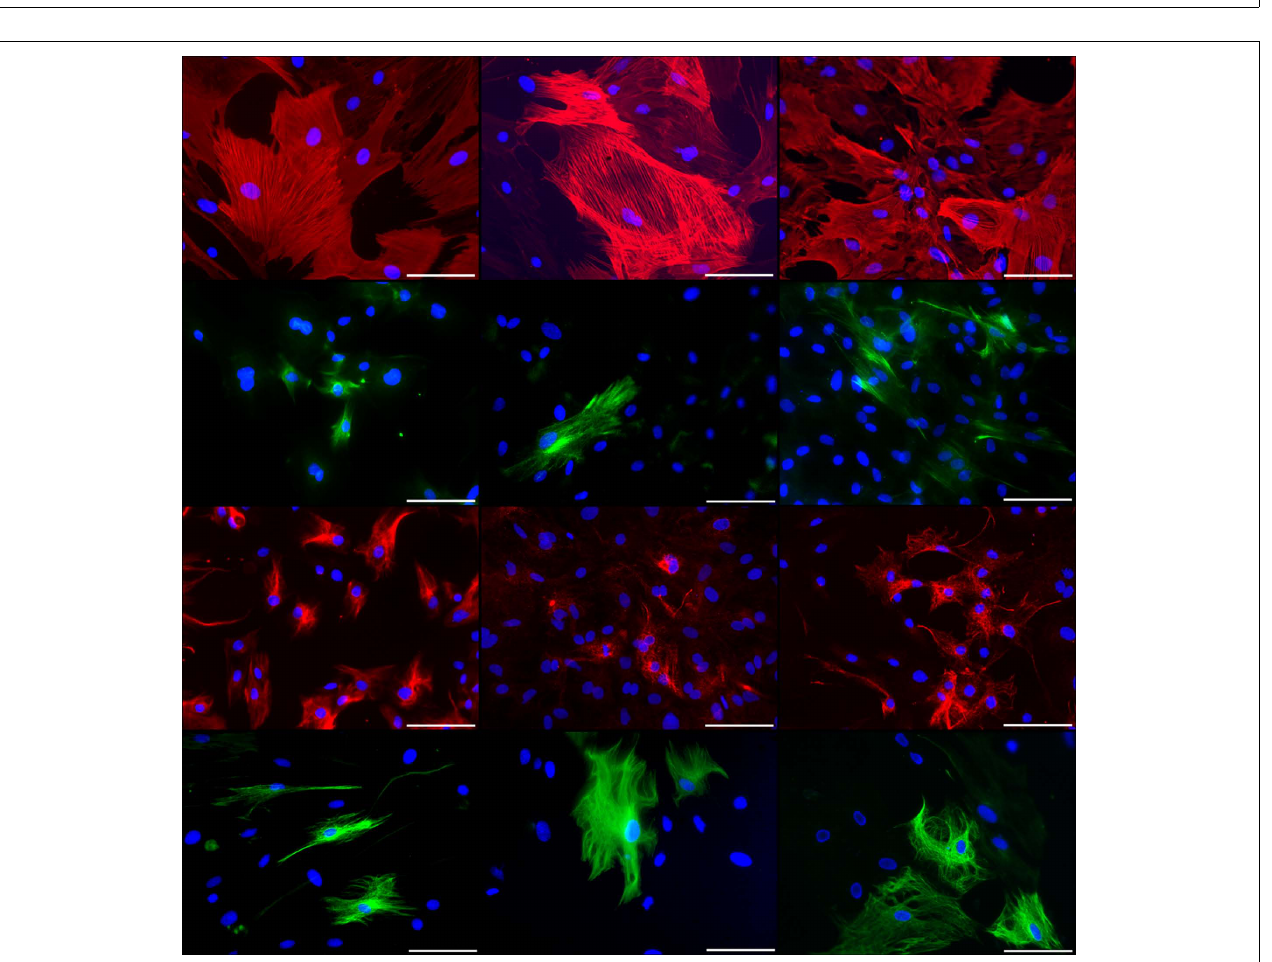
row). Secondary antibody in green was FITC-labeled goat-anti-rabbit and in red was Cy3-labeled goat-anti-mouse.The nuclear counterstaining was made with DAPI. All scale bars represent 100 μ m. Images are made with an Axioskop2 or Axio Observer.Z1 (both Carl Zeiss GmbH, Oberkochen,